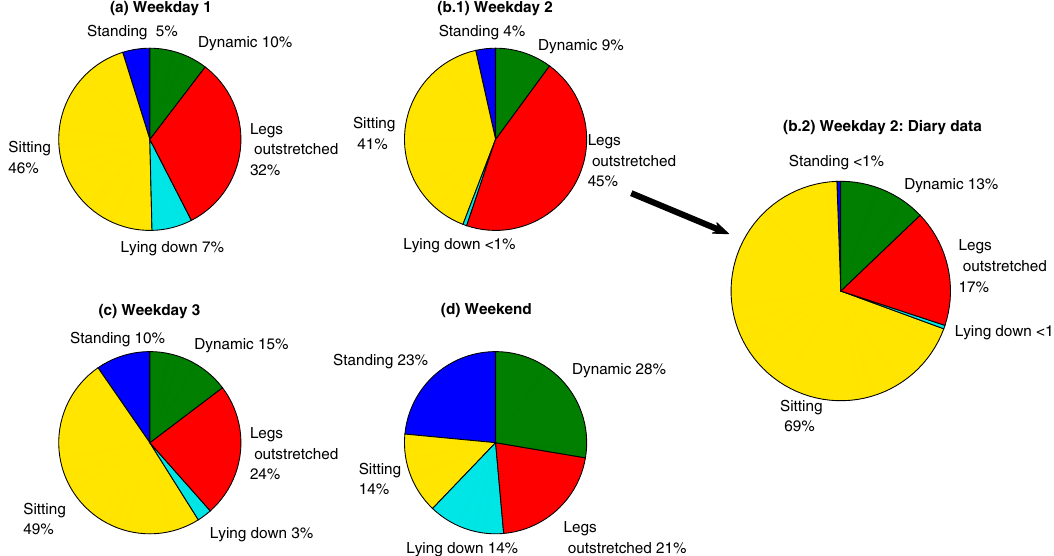
Figure 6. Four days’ activity summary report for ‘Participant A’, based on analysis of the sensor data ( a , b.1 , c and d ) and activity percentages based on diary data for Weekday 2 ( b.2 ). This includes three weekdays and one weekend day. Compared to weekdays, there was more standing and dynamic movements at the weekend. Also, the participant was sitting most of time during the weekdays with less time spent in dynamic